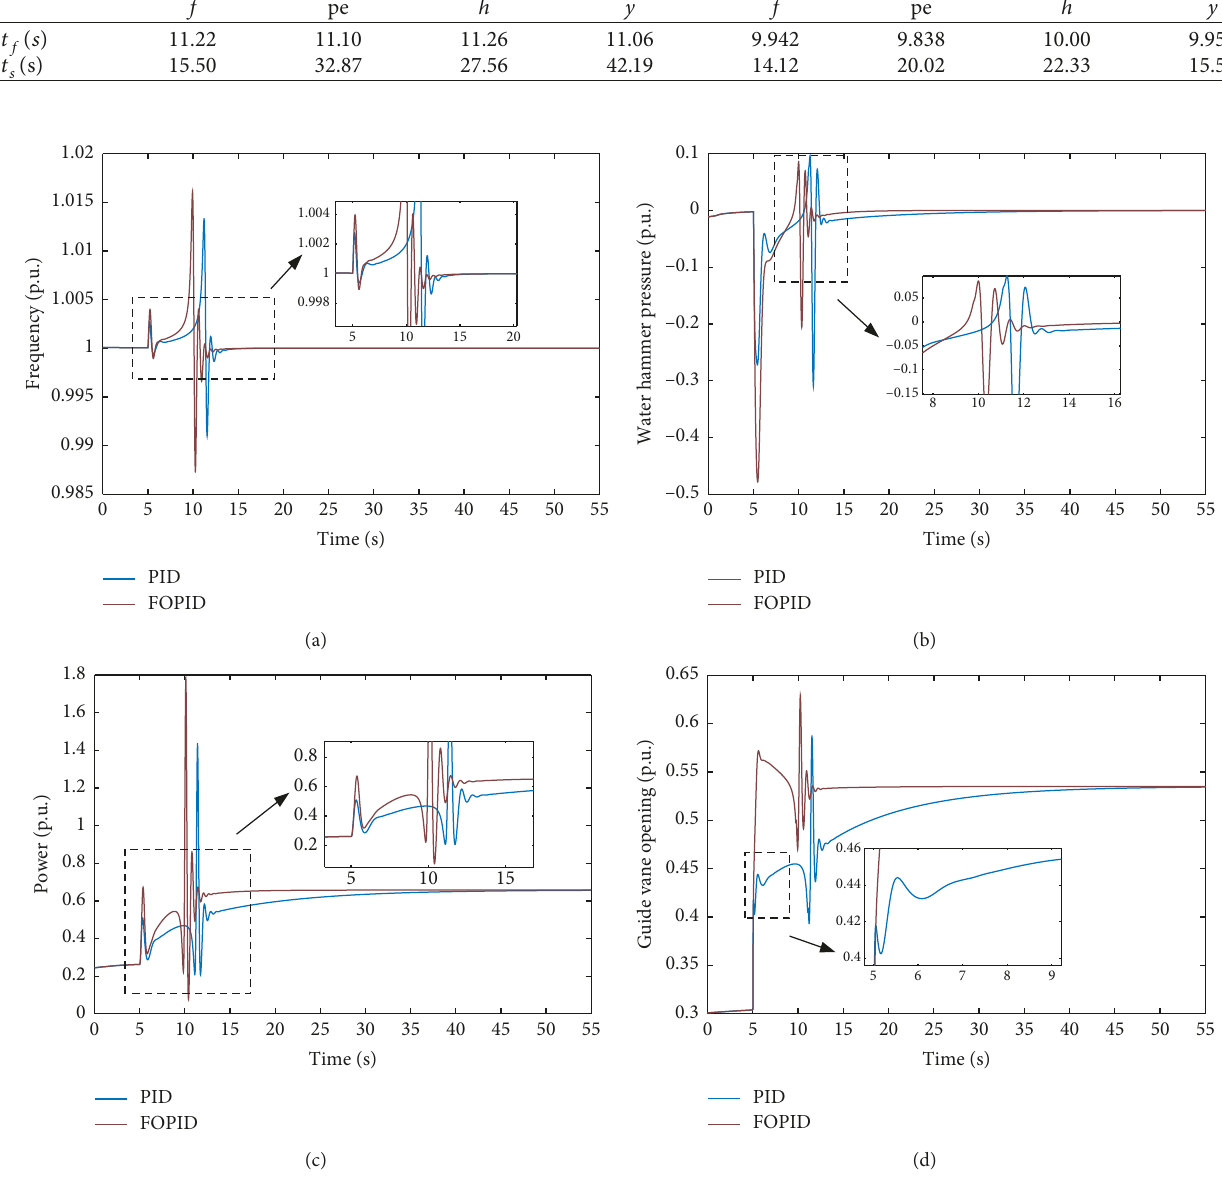
Figure 12: Dynamic response of each output with Δ f � + 0 . 5 Hz. (a) Frequency. (b) Water hammer pressure. (c) Power. (d) Guide vane